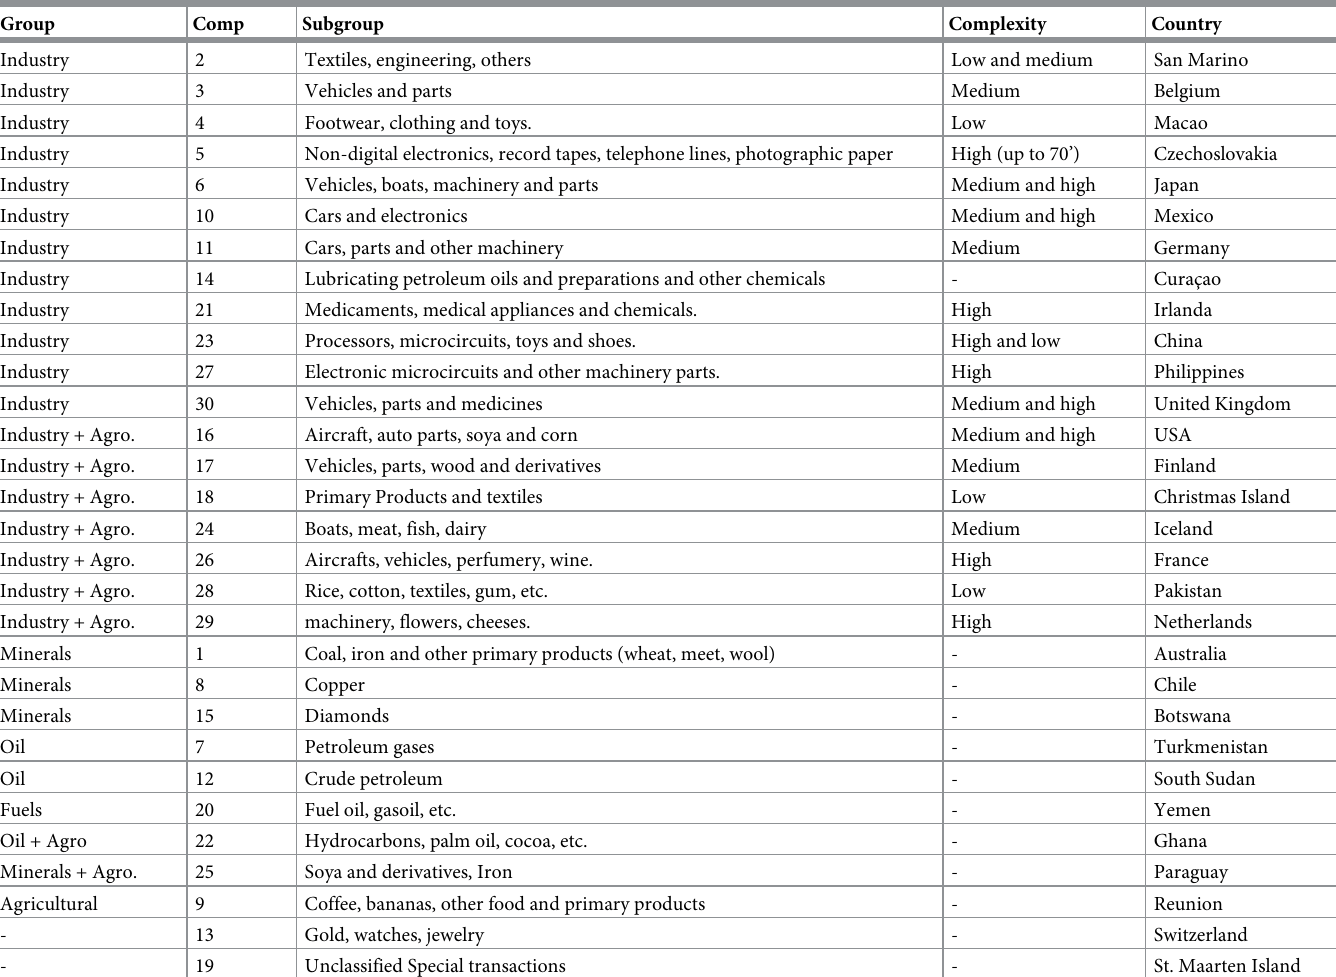
Table 1. Latent components. Groups, industrial complexity and representative country. k =